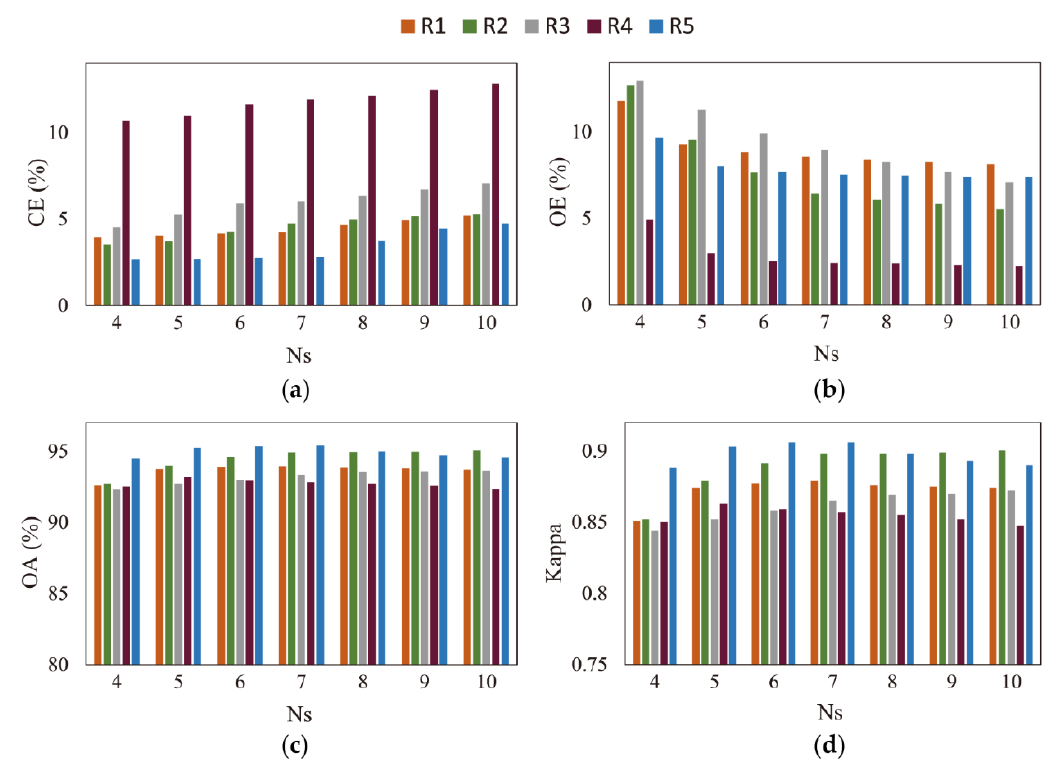
. ( a ) CE; ( b ) OE; ( c ) OA; ( d ) Kappa 𝑁𝑁 𝑠𝑠